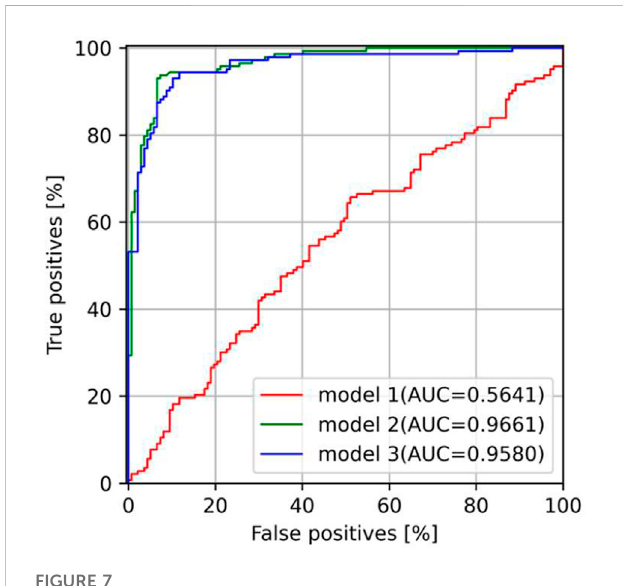
FIGURE 7 ROC and AUC for the three landslide susceptibility models.